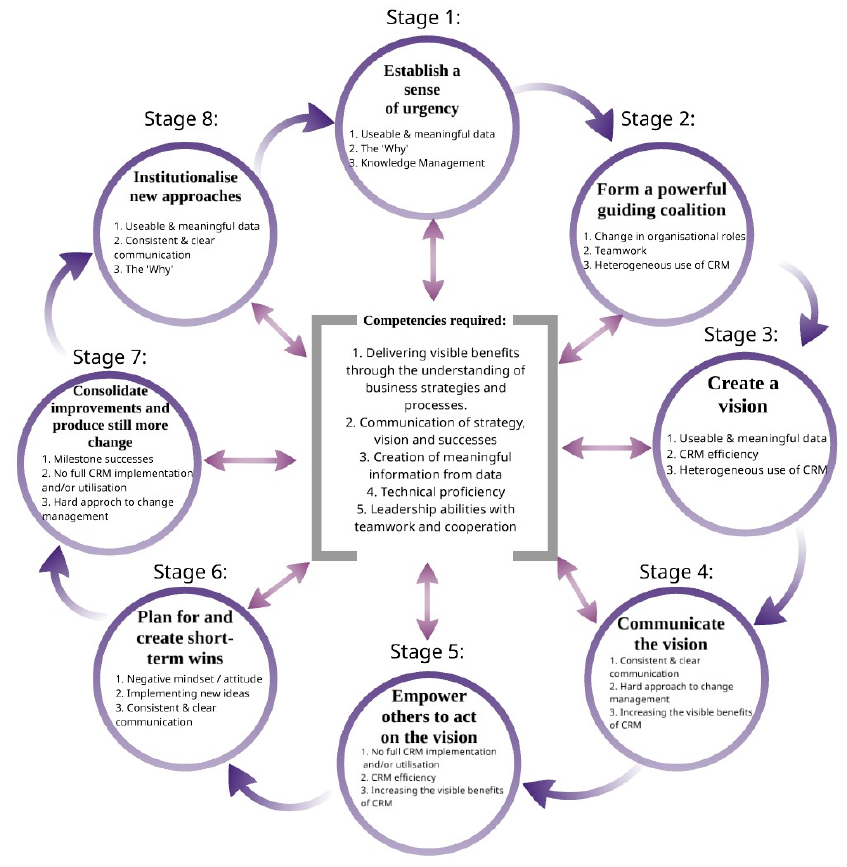
Figure 9. Adapted version of Kotter’s change model (Kotter 1996) for BI change projects.